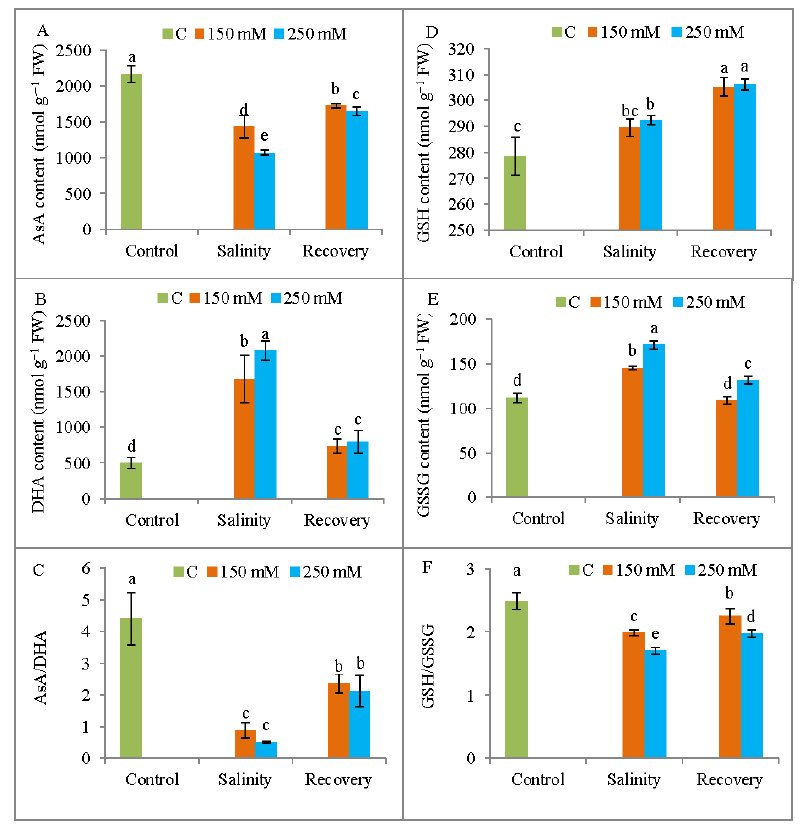
Figure 13. Content of AsA ( A ), dehydroascorbate (DHA) ( B ), AsA / DHA ratio ( C ), GSH ( D ), GSSG( E ), and GSH / GSSH ratio ( F ) in tomato plants under salinity (150 and 250 mM NaCl) and after a 48 h recovery period. Data means ( ± SD) were calculated from three replications. Statistically significant values are indicated by dissimilar letters (Fisher’s LSD test, P ≤ 0.05).